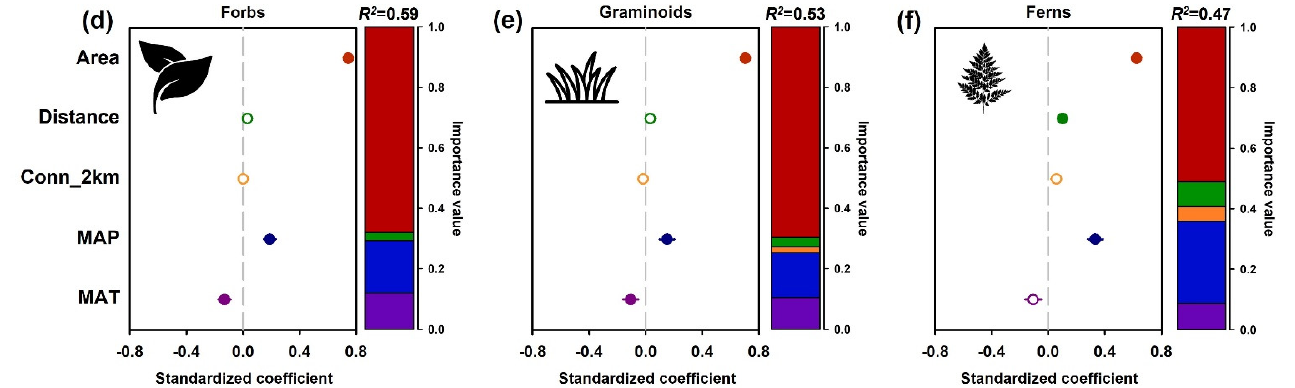
Figure 4. Standardized parameter estimates represent the effects size (circle) with standard error (bar) of five environmental factors for the species richness of ( a ) whole, ( b ) trees, ( c ) shrubs, ( d ) forbs, ( e ) graminoids (sedges, grades, and rushes), and ( f ) ferns in overall islands. The closed and open circles indicate significant and non-significant relationships between species richness and environ- mental factors, respectively. The relative importance of each factor was calculated as the ratio between the parameter estimate of the factor and the sum of all parameter estimates and then described as a percentage. In the left and right subgraphs of a graph, the same color represents the same variable. Abbreviations for the factors are shown in Figure 3.